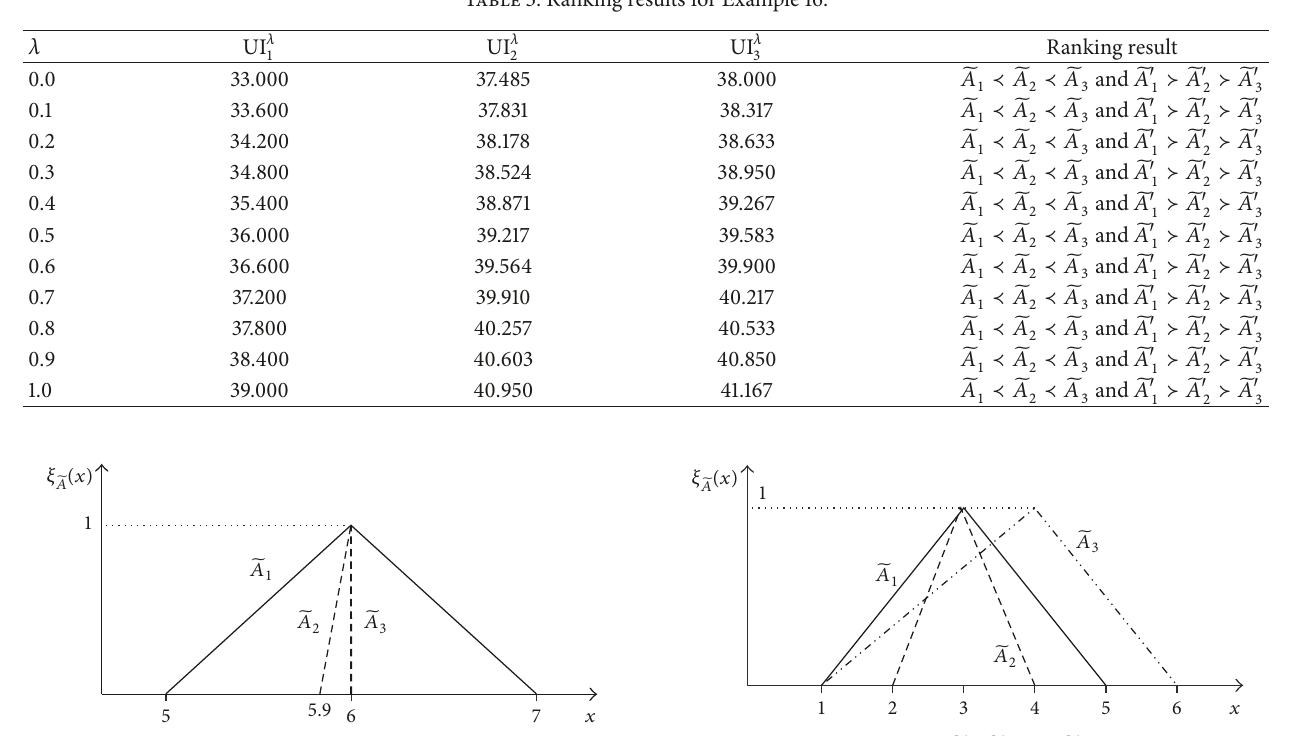
̃𝐴 ̃𝐴 ̃𝐴 1 , 2 , and 3 in Example 16.